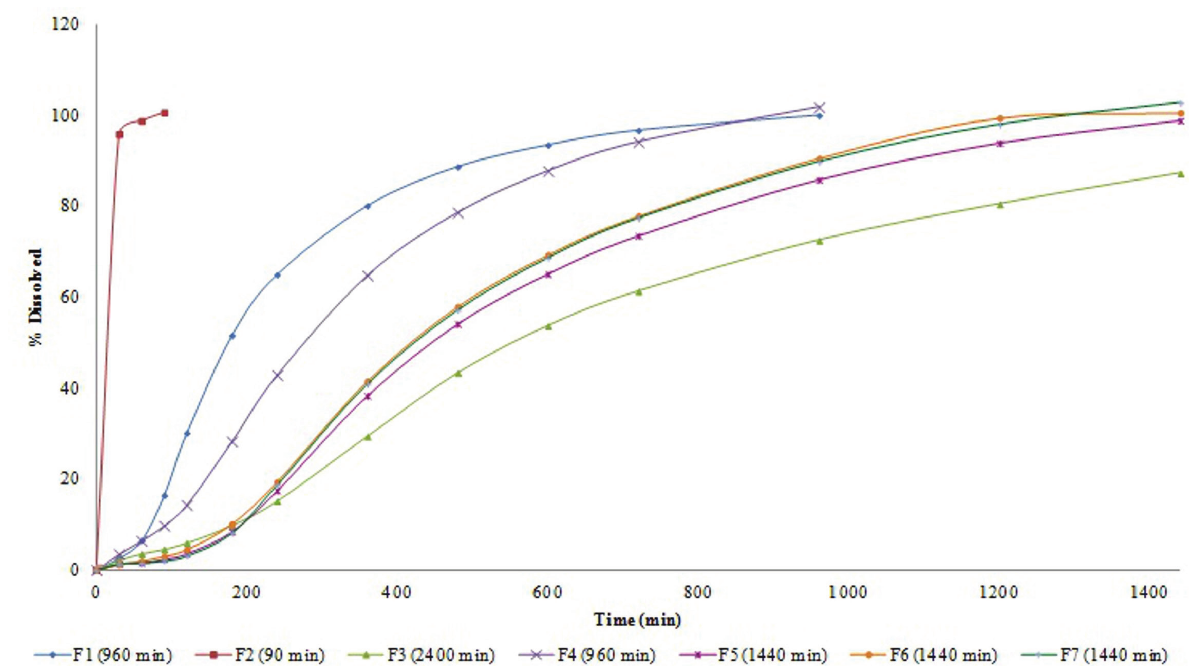
FIGURE 4 - Dissolution profiles of the formulations obtained in the experimental